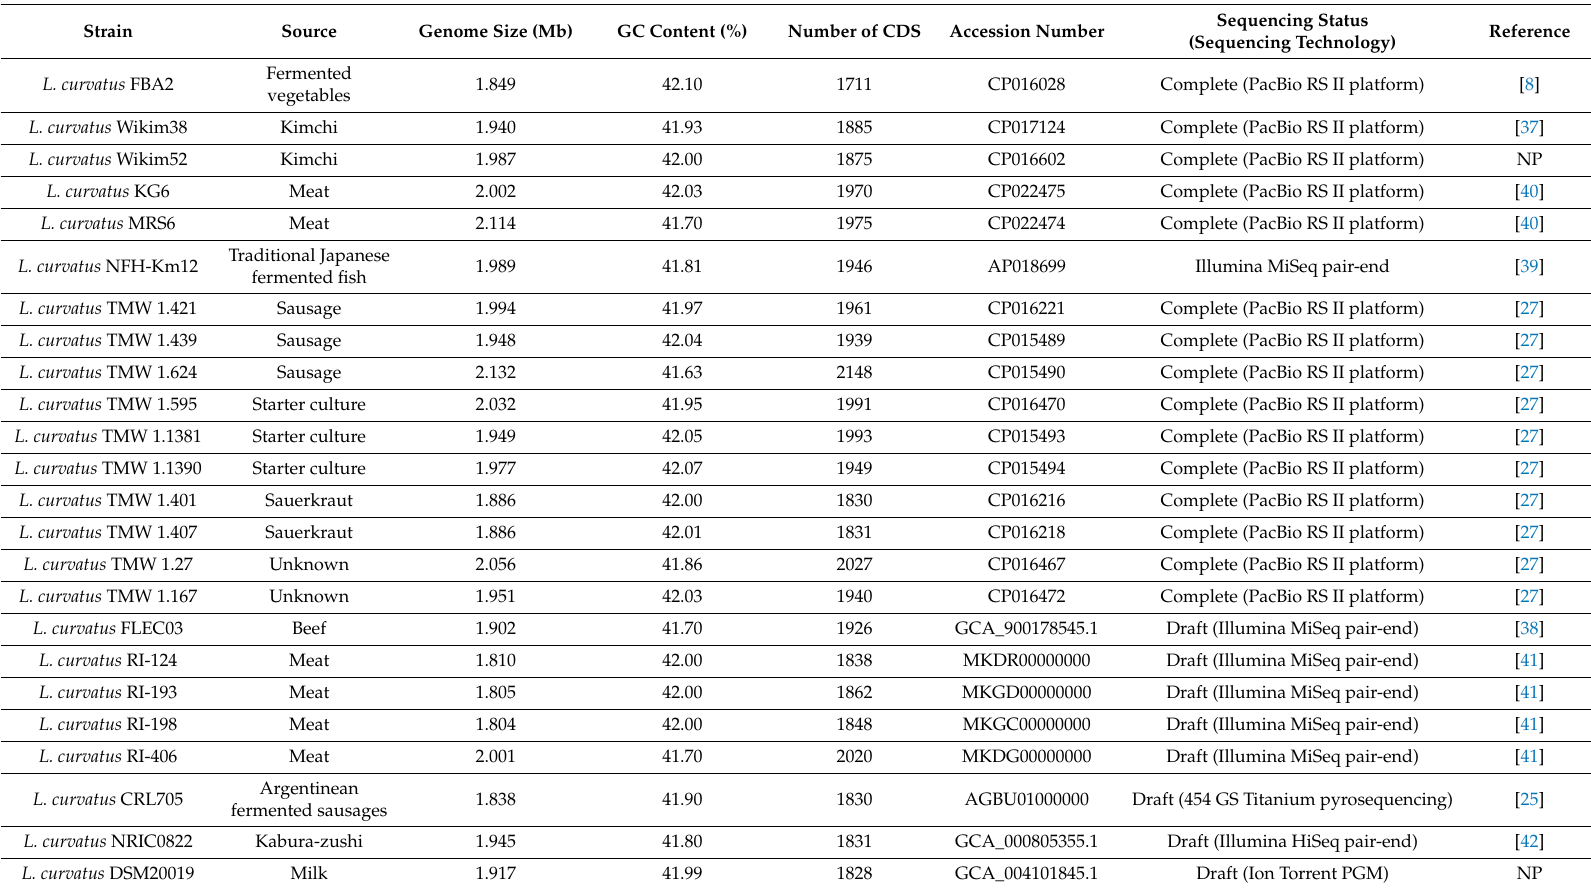
Table 1. Genome Sequences of Latilactobacillus curvatus